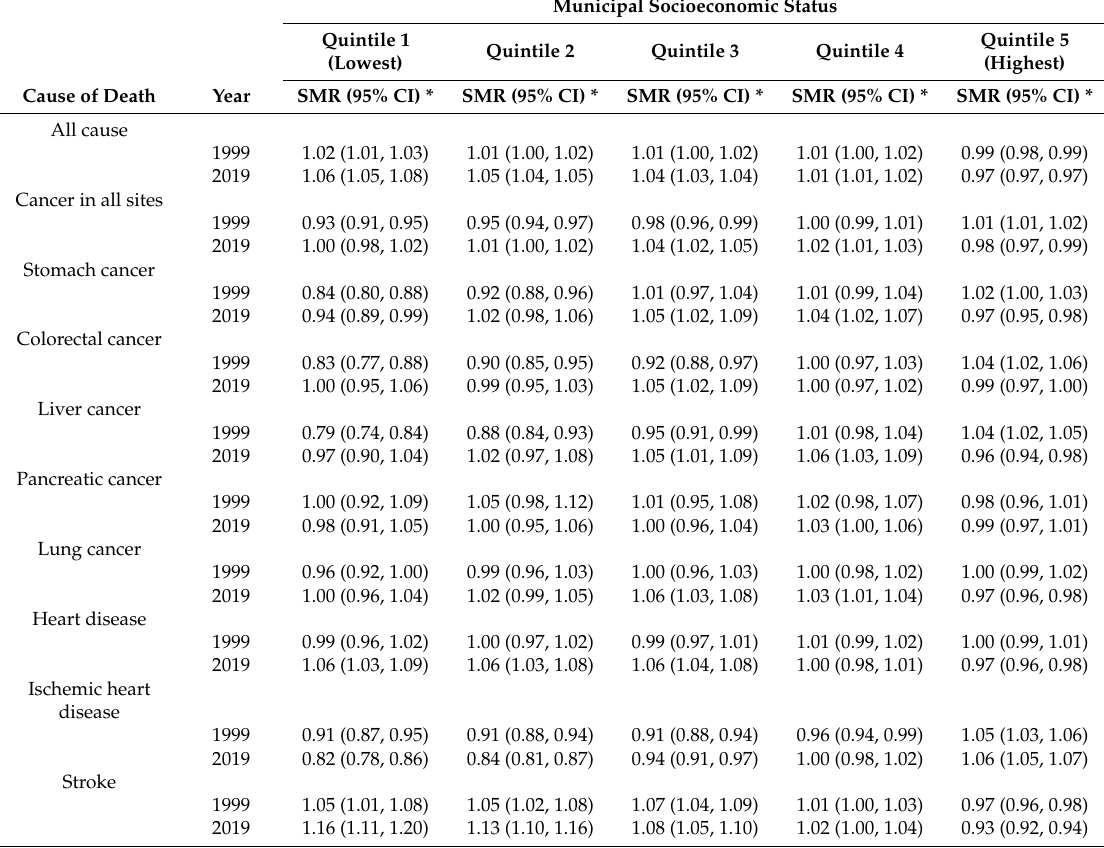
Table 3. SMR for all-cause and each cause of death by municipal SES quintile in 1999 and 2019 for